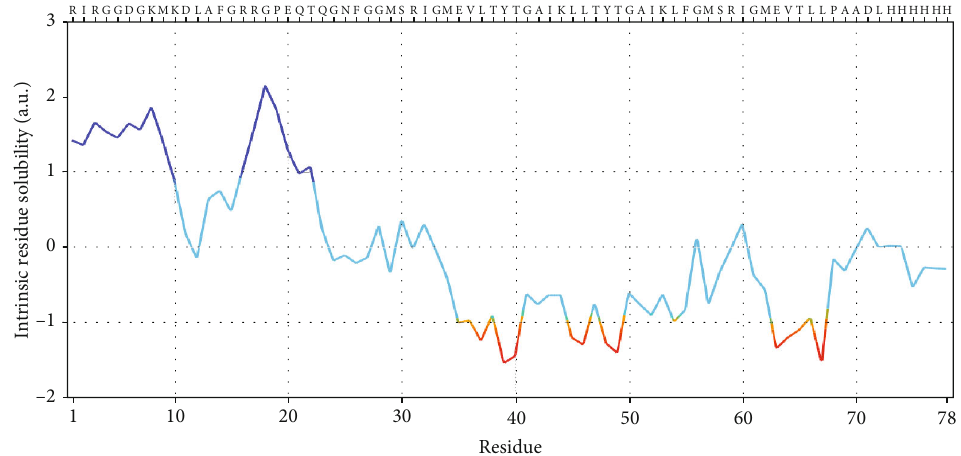
Figure 6: Solubility index pro fi le of the peptide vaccine. Residues less than -1 depict the hydrophobic core of the vaccine